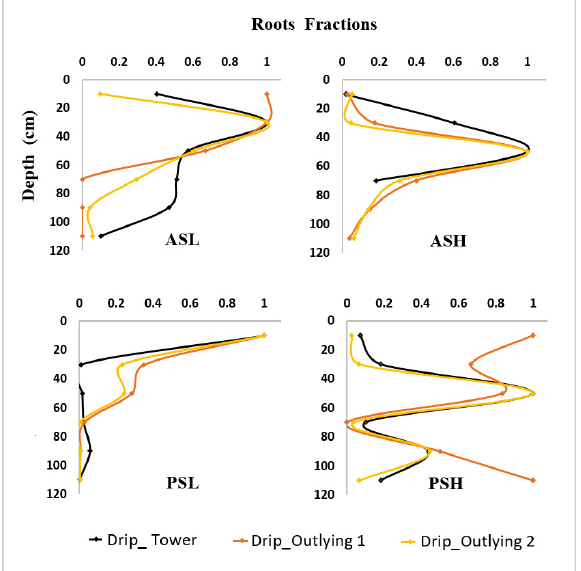
Figure 1. Measured relative spatial distributions (the maximum is one) of root densities of almond trees ( top ) at the ASL ( left ) and ASH ( right ) sites and of pistachio trees ( bottom ) at the PSL ( left ) and PSH ( right ) sites. The terms “Tower” and “Outlying” refer to sampling locations with respect to the eddy covariance tower [31].